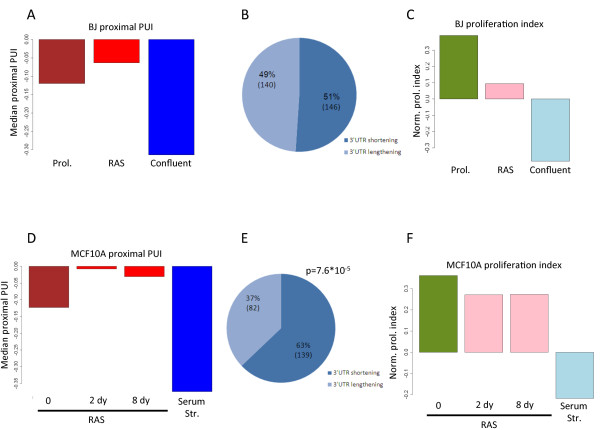
Relationship between APA and transformation. (a) Proximal PUIs calculated for proliferating, RAS-transformed and confluent BJ cells. (b) Distribution of APA events induced by RAS transformation according to net effect on transcript 3' UTR length. (c) Proliferation index calculated for proliferating, RAS-transformed and confluent BJ cells. (d) Proximal PUIs calculated for proliferating, RAS-transformed (2 and 8 days after RASG12V induction) and serum-starved MCF10A cells. (e) Distribution of APA events that were consistently induced by RAS transformation at both 2 days and 8 days, according to net effect on transcript 3' UTR length. (f) Proliferation index calculated for proliferating, RAS-transformed and serum-starved MCF10A cells.